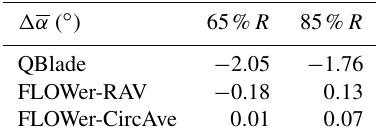
Table 11. Differences between the experiment and the different simulation results of the angle of attack for CaseYAW15.